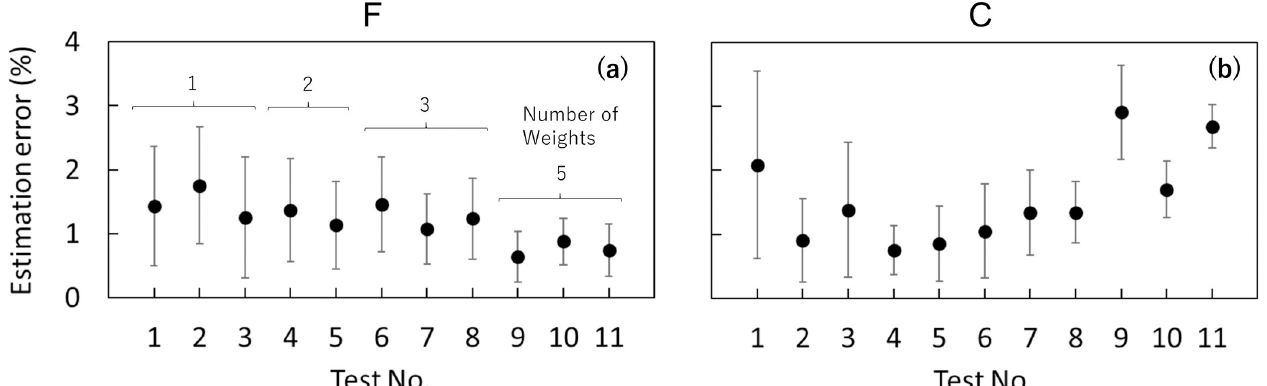
Fig 5. Estimation errors for the distributed load experiment. (a) The amount of force, F, and (b) the centroid of the distributed force, C, shown in the order of the distributed loading tests (for the details of each test, see Table 1). The number of loading weights is the same in panels (a) and (b). The estimation error for F and C was defined as the absolute value of [1 –(estimated value) / (known value)] × 100 (%).